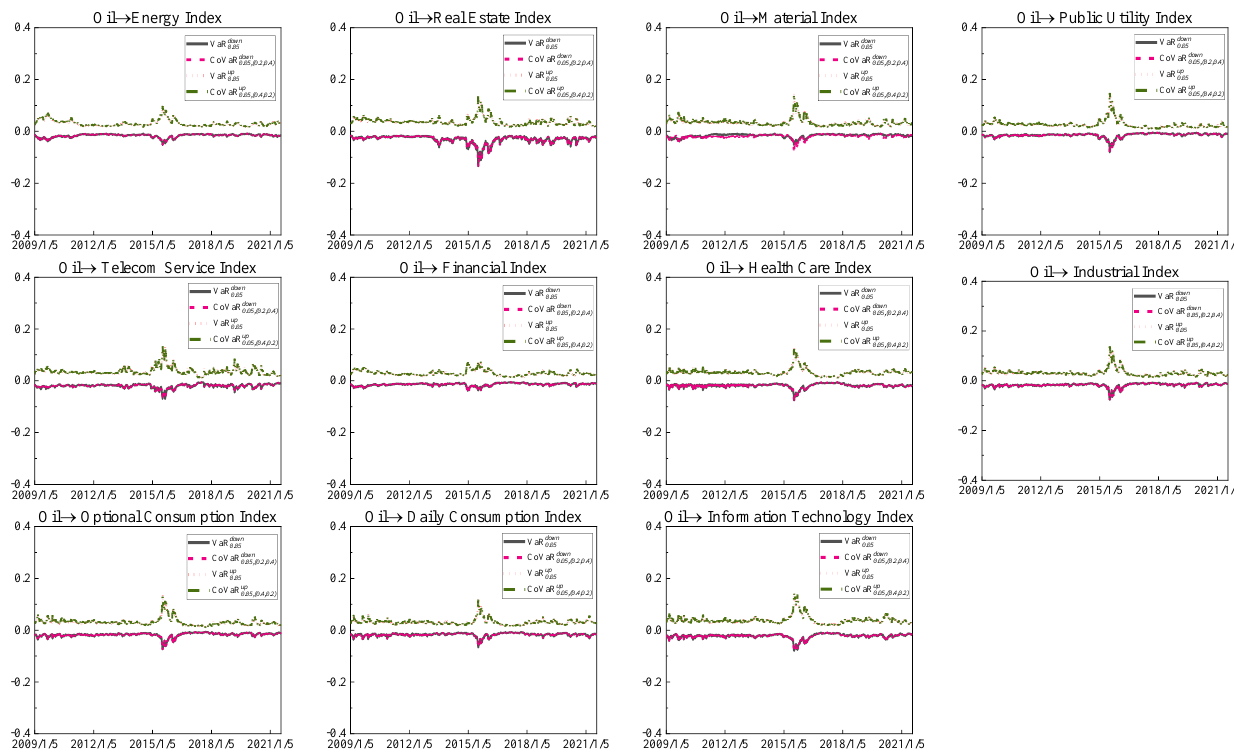
Figure 2. Tail risks of moderate oil market on Chinese sector stock markets. Table 8. Descriptive statistics of tail risk of moderate oil market on Chinese sector stock markets.